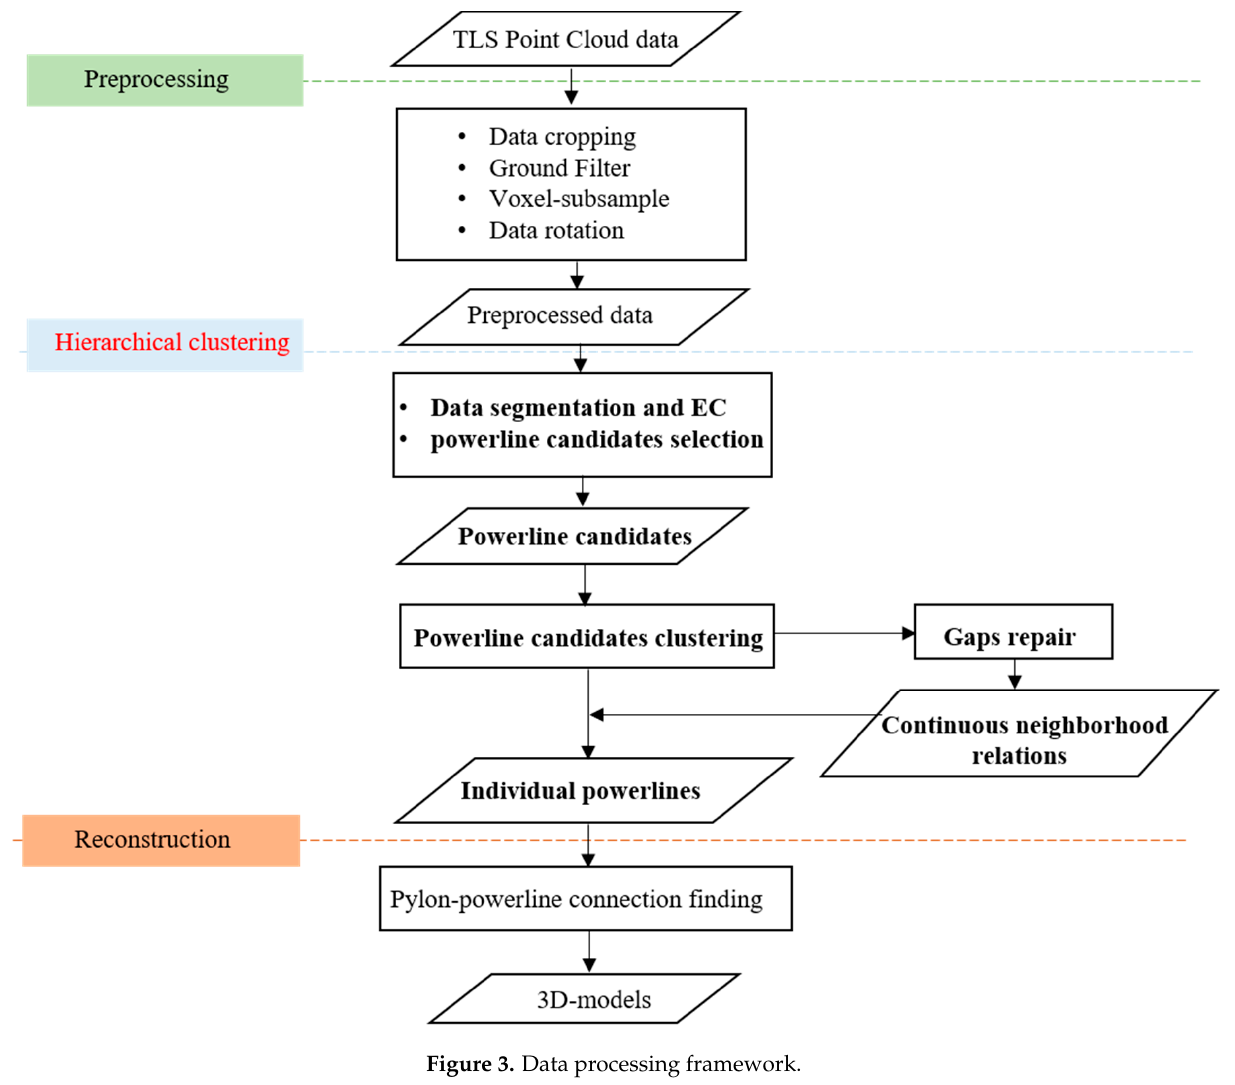
Figure 3. Data processing framework.